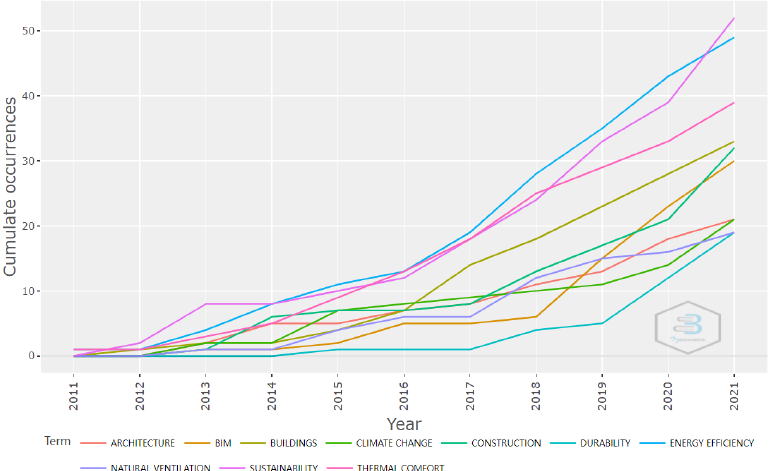
Figure 5. Growth of the top 10 keywords.